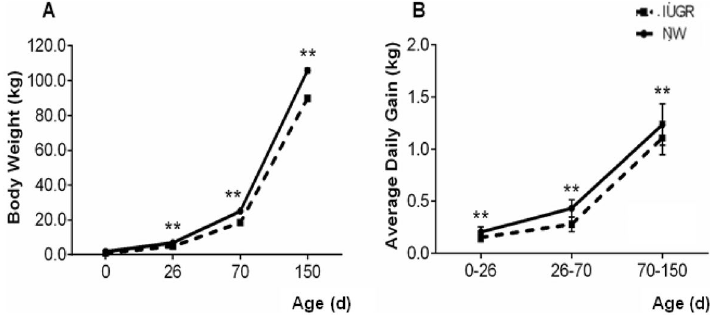
Figure 1. Growth curve ( A ) and average daily gain ( B ) in growth restricted (IUGR) and normal (NW) birth weight male littermate pigs from birth (0) to 150 days of age. IUGR pigs grew slower and gained less body weight throughout the production phases. Double asterisk: means differ statistically between groups (P < 0.001). Error bars represent the standard errors of the